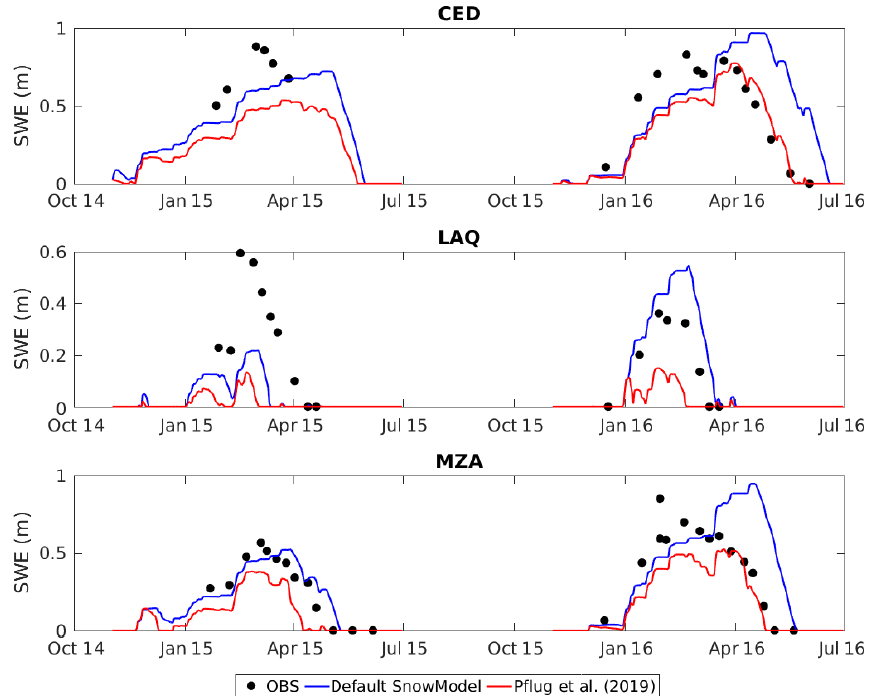
Figure 3. Time series of observed and modeled daily SWE at each AWS. SWE data were obtained from manual sampling during snow course measurements.